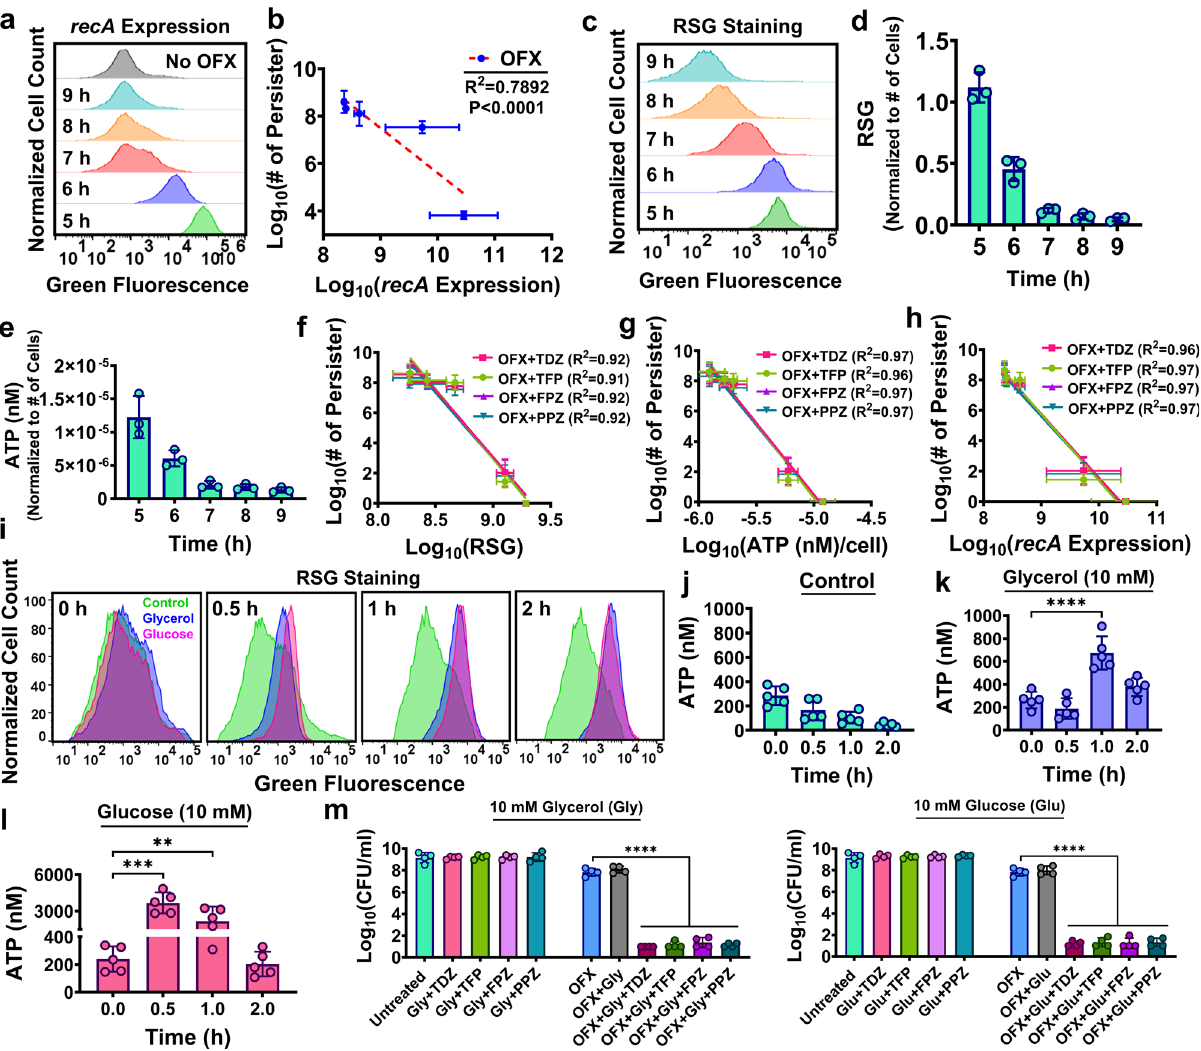
Fig. 7 Metabolic stimulation can potentiate OFX and phenothiazine activities in stationary phase E. coli MG1655 cells. a Induction of recA expression by OFX in stationary phase. E. coli cells with P recA -gfp were treated with OFX at the indicated time points ( t = 5 – 9 h). After a 20 h treatment, cells were analyzed by fl ow cytometry to measure GFP expression levels, and cells were collected and plated for viable cell counts. A representative fl ow cytometry diagram is shown. All independent biological replicates showed a similar trend. n = 3. b Correlation between persister levels and recA during stationary phase. A linear regression analysis between persister levels of OFX-treated cultures and recA expression was performed using the data obtained from panel a. P < 0.0001 ( F -statistics). c , d RSG staining of stationary phase cells. E. coli MG1655 WT cells at indicated time points in the transition to stationary phase ( t = 5 – 9 h) were stained with RSG dye to measure their redox activities by fl ow cytometry. A representative fl ow cytometry diagram is shown. All independent biological replicates showed a similar trend. n = 3. e ATP measurement of stationary phase cells. ATP concentrations were determined for cells at indicated time points in the transition to stationary phase ( t = 5 – 9 h). n = 3. f Correlation between persister levels and cellular redox activities. A linear regression analysis between cellular redox activities (data from panel d ) and persister levels of co-treated cultures (data from Supplementary Fig. 12) was performed, where P < 0.0001 ( F -statistics). g Correlation between persister levels and cellular ATP levels. A linear regression analysis between cellular ATP levels (data from panel e ) and persister levels of co-treated cultures (data from Supplementary Fig. 12) was performed, where P < 0.0001 ( F -statistics). h Correlation between persister levels and recA expression. A linear regression analysis between cellular recA expression (data from panel a ) and persister levels of co-treated cultures (data from Supplementary Fig. 12) was performed, where P < 0.0001 ( F -statistics). i – l Metabolic stimulation of stationary phase cells with carbon sources. Mid-stationary phase E. coli MG1655 WT cells were supplemented with glycerol (10 mM), glucose (10 mM), or neither. At indicated time points, 100 μ l of cell cultures were collected to measure their redox activities and ATP levels (nM). A representative fl ow diagram is shown. All independent biological replicates showed a similar trend. n = 3. m Survived cell levels in metabolically stimulated co-treated cultures. Cells at mid-stationary phase ( t = 12 h) were treated with (i) OFX only, (ii) OFX + phenothiazine drugs, or (iii) phenothiazine drugs 30 min after adding glycerol or glucose to the cultures. After a 20 h treatment, cells were plated for viable cell counts. TDZ: 0.25 mM; TFP: 0.5 mM; FPZ: 0.5 mM; PPZ: 0.5 mM. n = 4. Statistical analysis was performed between the control and treatment group using one-way ANOVA with Dunnett ’ s post-test. ** P < 0.01, *** P < 0.001, and **** P < 0.0001. Data corresponding to each time point represent mean value ± standard deviation.